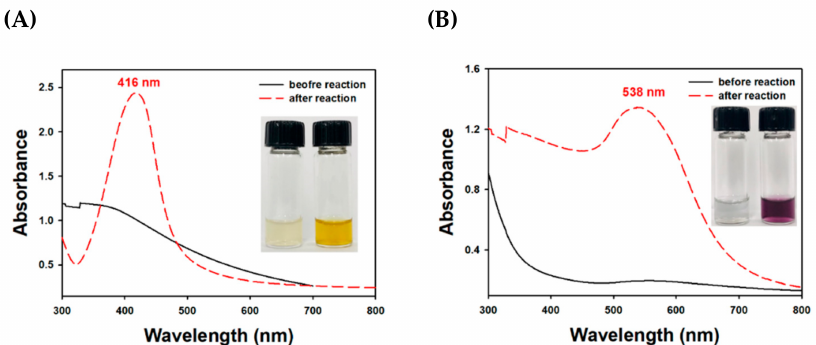
Figure 2. UV-visible spectra of ( A ) TF-AgNPs and ( B ) T. farfara gold nanoparticles (TF-AuNPs). The inset shows the digital photographs before oven incubation (left) and after oven incubation (right) in each